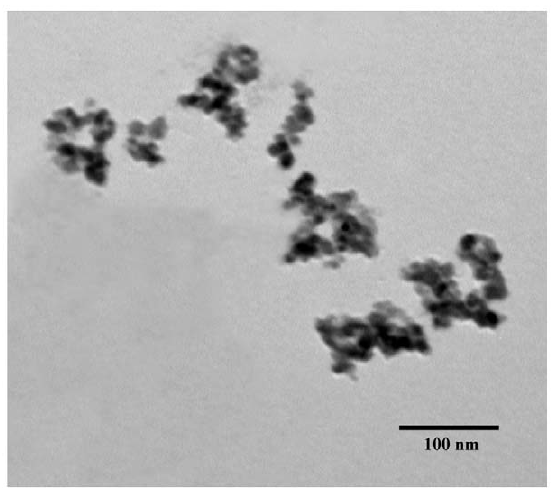
Figure 6. TEM image of 9 nm DMSA coated Fe 2 O 3 -nanoparti- cles.